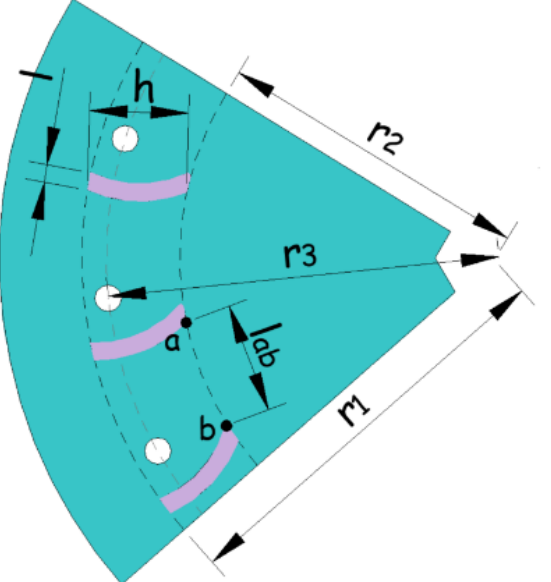
(11) Figure 8. Arch surface contour curve of garlic. Because of the large and irregular seeds of garlic seeds, which lead to poor mobility